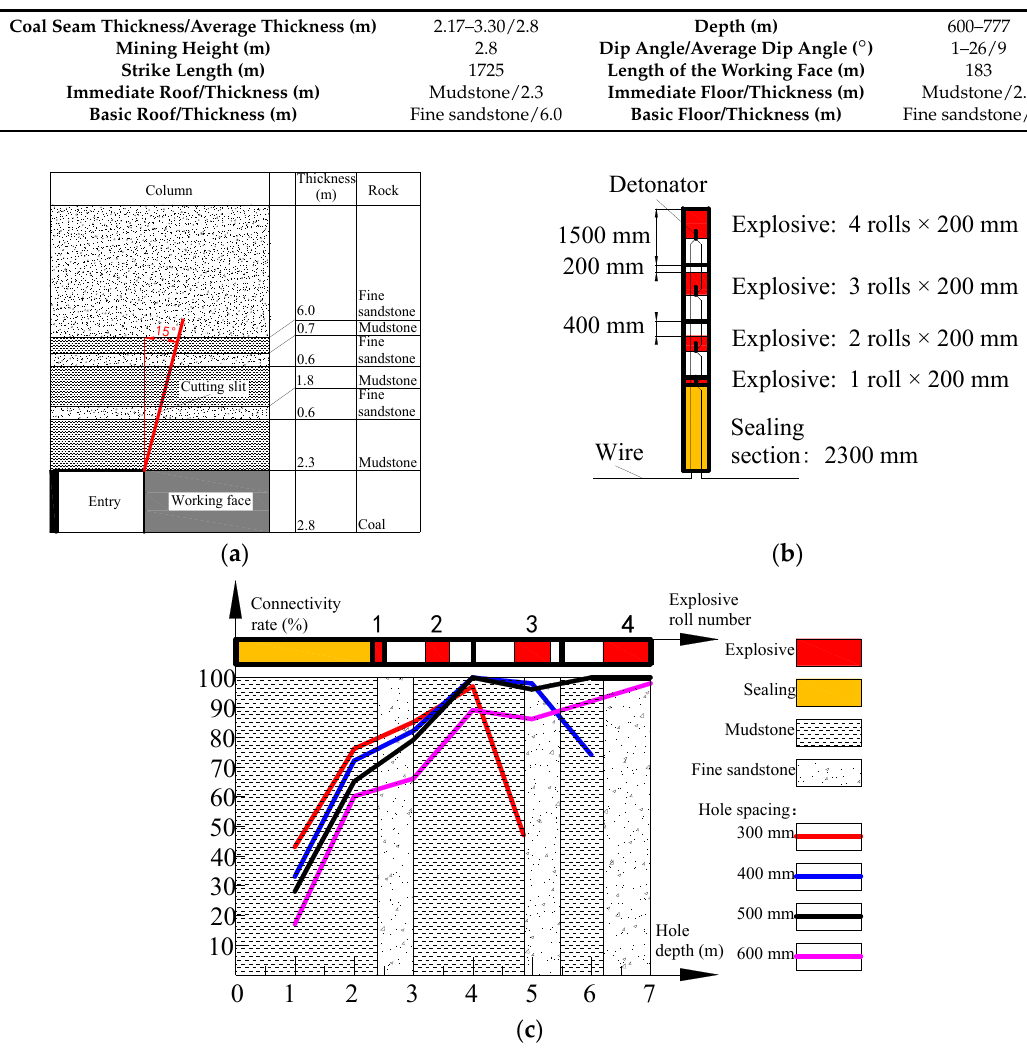
Figure 12. Roof cutting blasting design of the II632 working face: ( a ) roof cutting design; ( b ) schematic of charge structure; ( c ) statistical drawing of roof cutting connectivity rate.